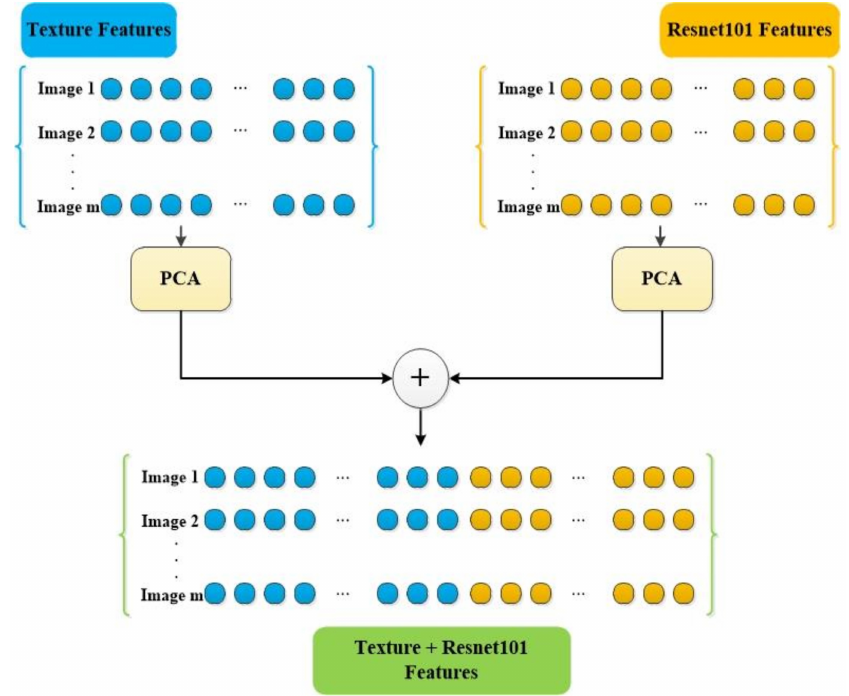
Figure 4. Schematic representation of the extracted feature fusion vector. PCA: principal component